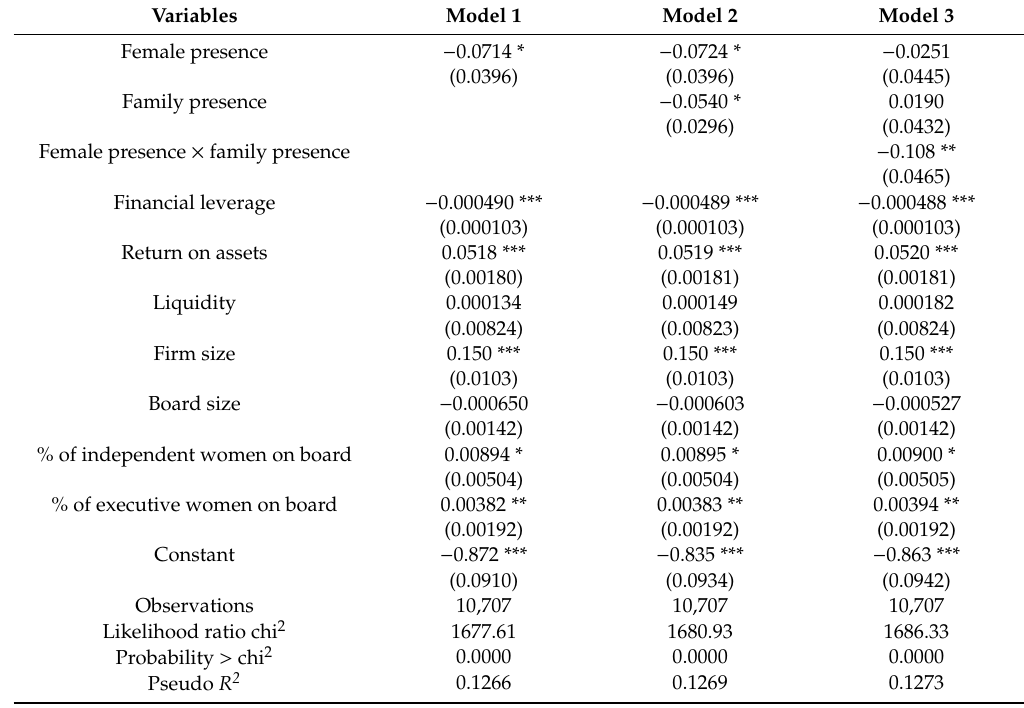
Table 6. Regression results (dependent variable: dividend announcement) for Asian emerging